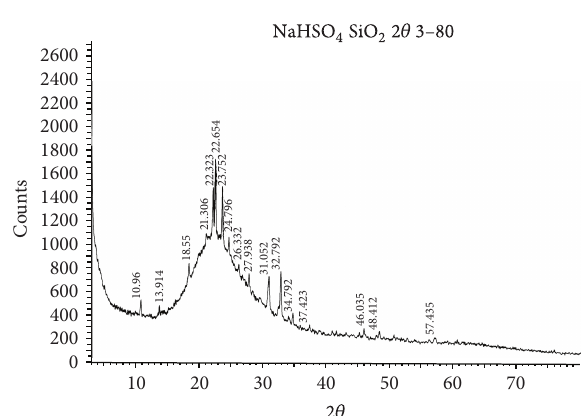
F 2: XRD spectra of silica-supported sodium hydrogen sul-